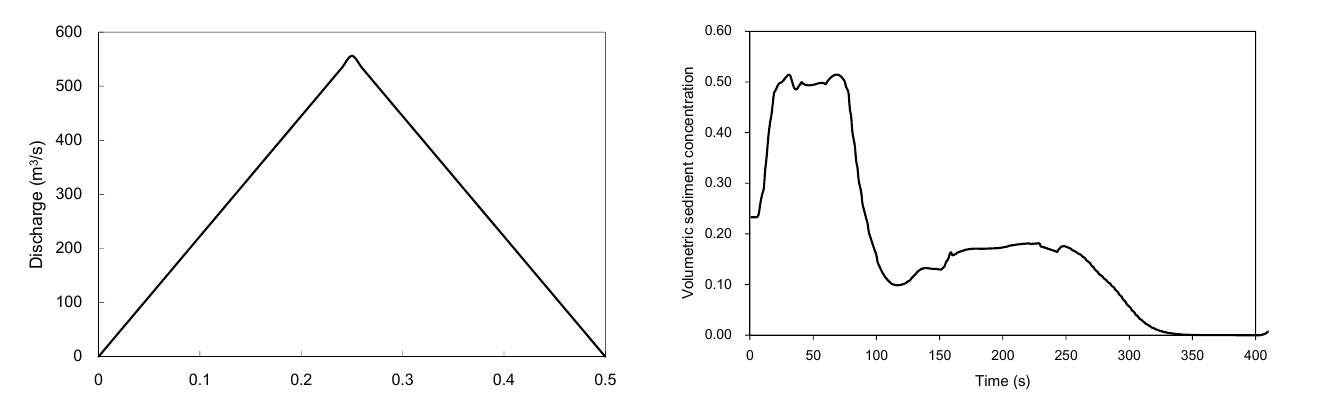
Figure 17. Change of volumetric sediment concentration at Section 3-3 in Fig.